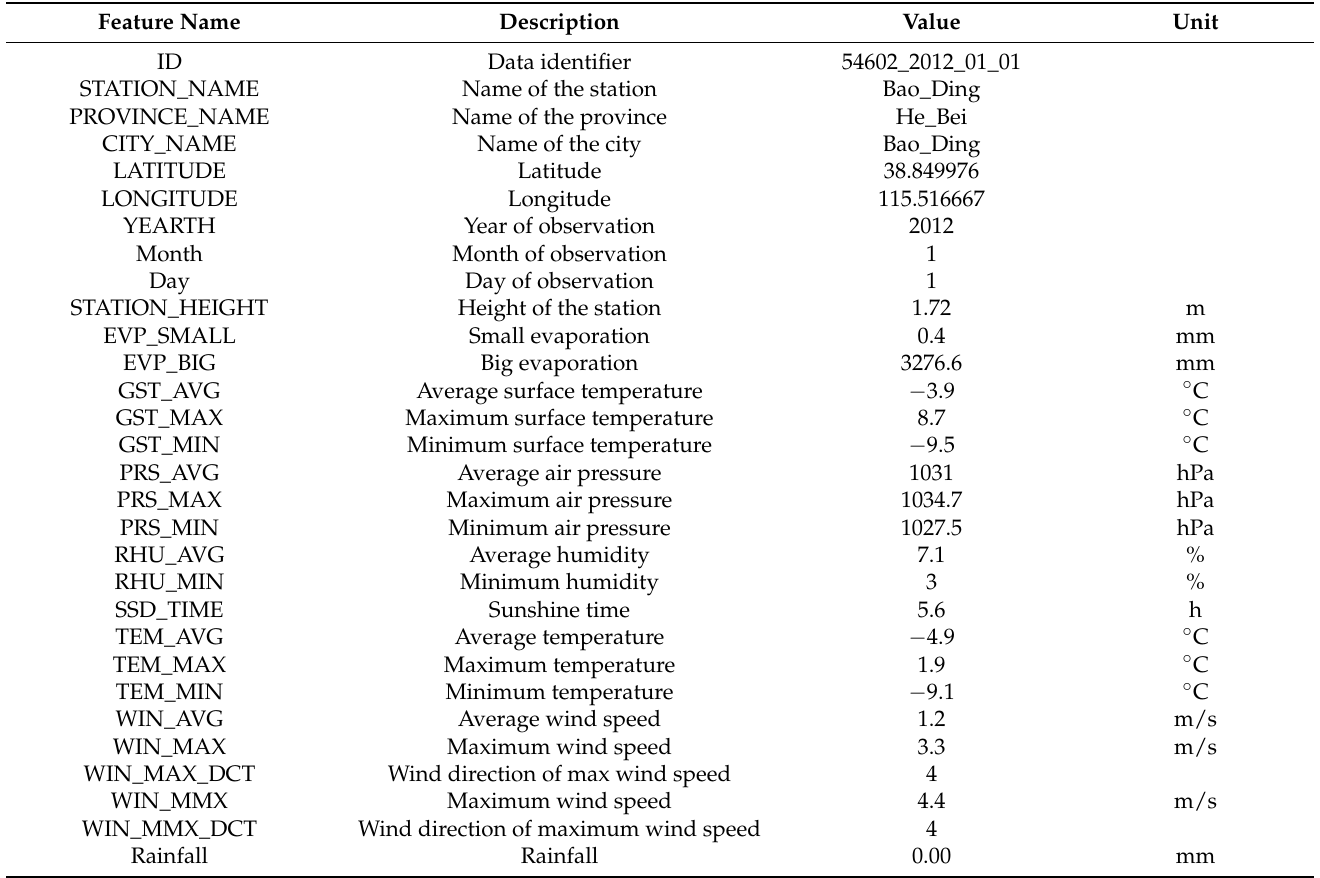
Table 1. Details the data.